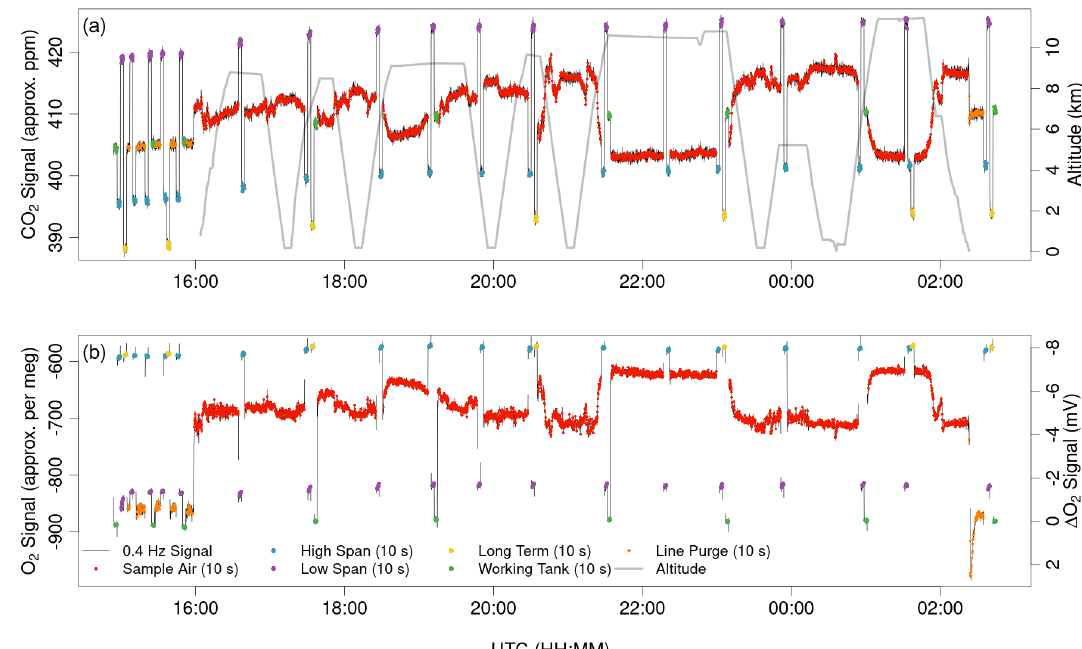
Figure 5. AO2 CO 2 and O 2 signals from ATom-4 Research Flight 2, from Palmdale, California, to Anchorage, Alaska, with profiles over the northeast Pacific and Arctic oceans. CO 2 signals are from the internal Li-820 sensor and O 2 signals are the amplitude of the 5s square wave, converted to approximateppm and per meg using a single linear calibration for the entire flight for each species. The calibration intervals include the last 1h 15min of preflight with line purge gas on the sample line and calibration cycles every 15min, in-flight calibrations nominally spaced by 50min, and 15min of postflight line purge and a final calibration cycle. The anticorrelated vertical gradients in CO 2 and O 2 are consistent with buildup of industrial emissions and respiration over winter and late